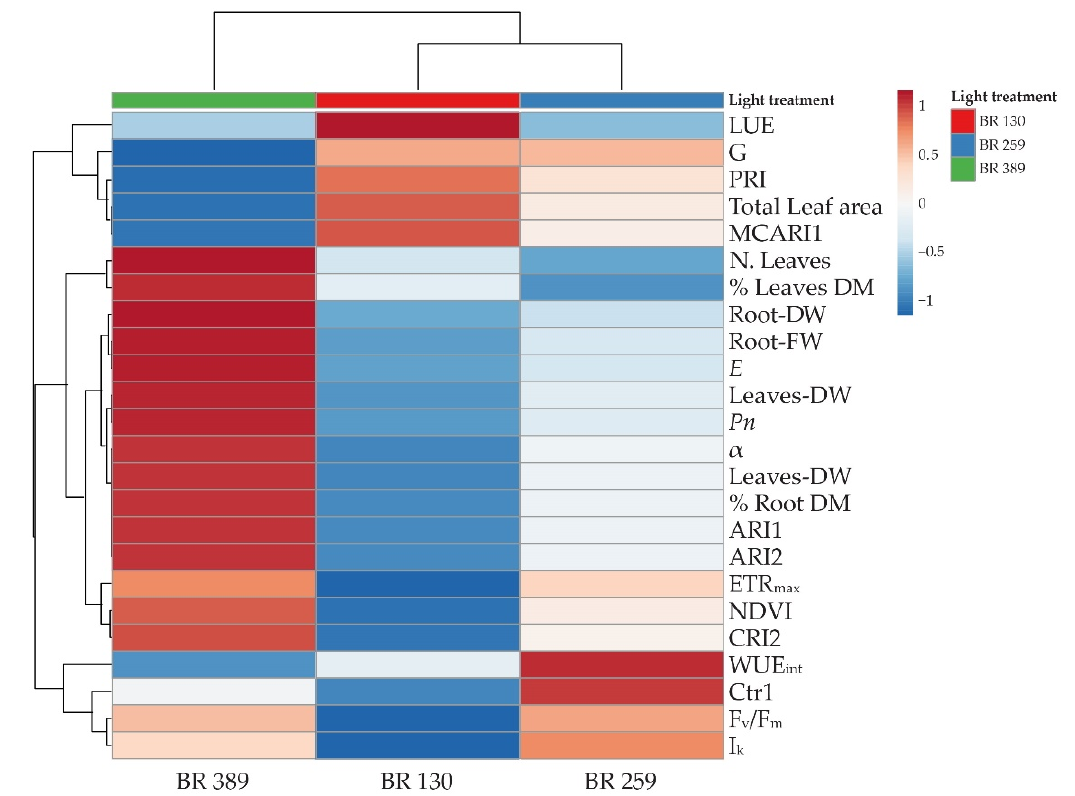
Figure 5. Heatmap cluster analysis on leaf net photosynthesis ( Pn ), leaf transpiration ( E ), leaf photosynthesis light use efficiency (LUE), and intrinsic water use efficiency (WUE int ). Chlorophyll a fluorescence parameters: maximal electron transport rate (ETR max ), minimum saturating irradiance (I k ), the slope of the curve ( α ). The vegetation indexes: normalized difference vegetation index (NDVI), modified chlorophyll absorption reflectance index 1 (MCARI1), greenness index (G), photochemical reflectance index (PRI), Carter index 1 (Crt1), anthocyanin reflectance index (ARI1, ARI2) and carotenoid reflectance index 2 (CRI2), and growth parameters: leaf number, total plant leaf area, fresh leaves weight (leaves FW), fresh root weight (root FW), dry leaf weight (leaves DW), dry root weight (root DW), dry leaf matter (%) (leaves DM), dry root matter (%) (root DM) of Ba- tavia lettuce cv ‘Blackhawk’ grown under three different light intensities (130, 259, 389 µmol m − 2 s − 1 ). Original values are ln (x + 1) transformed; data are expressed with Euclidean distances and hierarchical clustering with complete linkage.